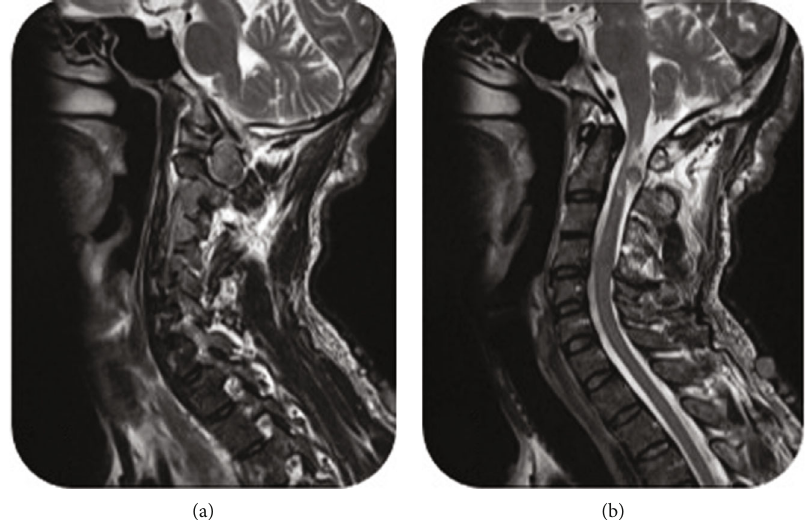
Figure 3: Sagittal T2WI showing expanded intervertebral foramina mostly at C1-C2 level (a) and dorsal intradural part of bilateral C2 ganlion GN, compressing spinal cord and causing signal change at highest cervical spinal cord segments.